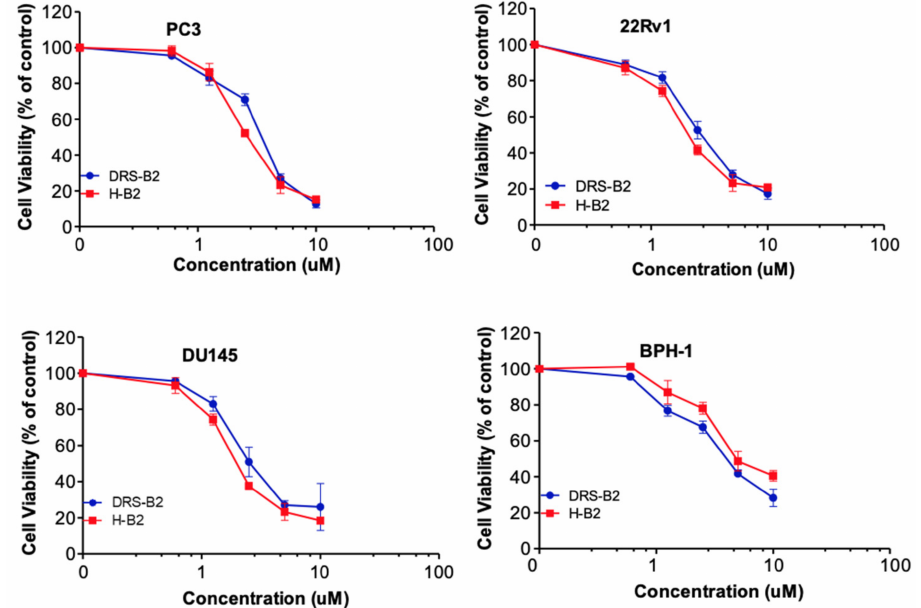
Figure 2. Sensitivity of human PCa cell lines to H-B2 is dependent on LHRH-R expression. The dose–response effect of H-B2 and DRS-B2 (0.1 to 100 µ M) on the cell viability of PC3, DU145, 22Rv1 and BPH-1 cells was evaluated using MTT assay. The 100% of cell viability corresponds to cells without treatment.